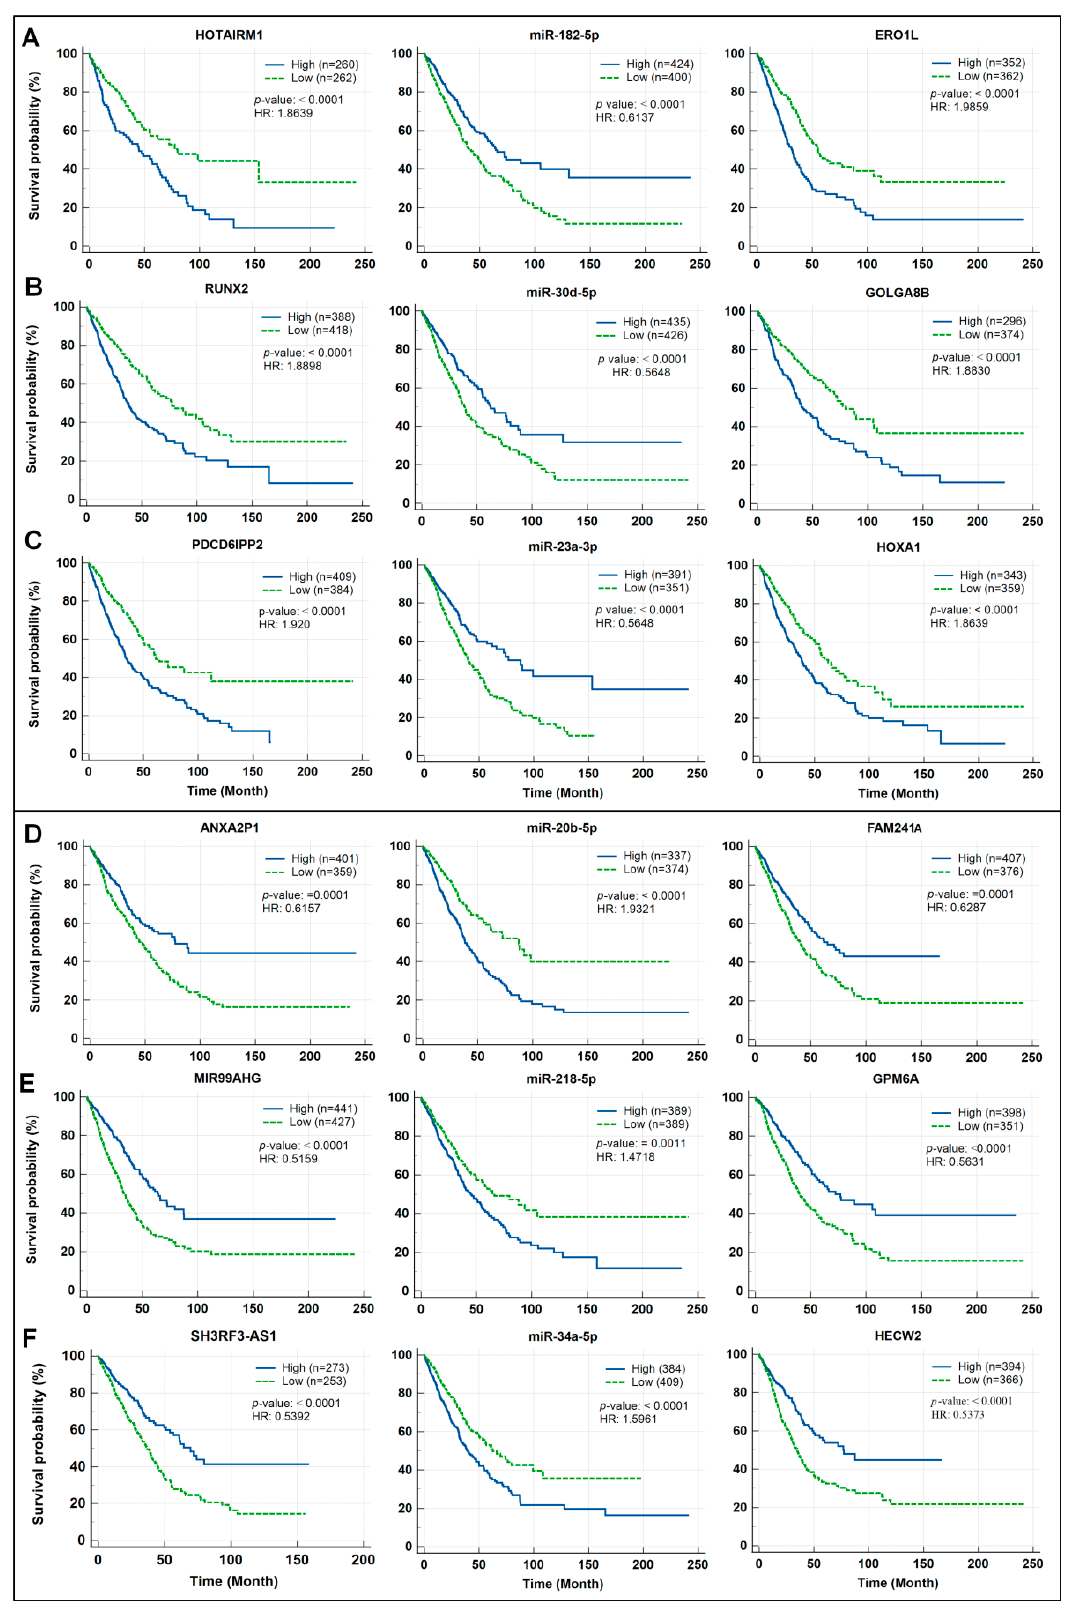
Figure 8. Survival analysis and prognostic performance of selected ceRNA modules in lung cancer. The Kaplan–Meier survival analysis of oncogenic regulatory axes ( A – C ) and tumor suppressor regulatory axes ( D – F ).